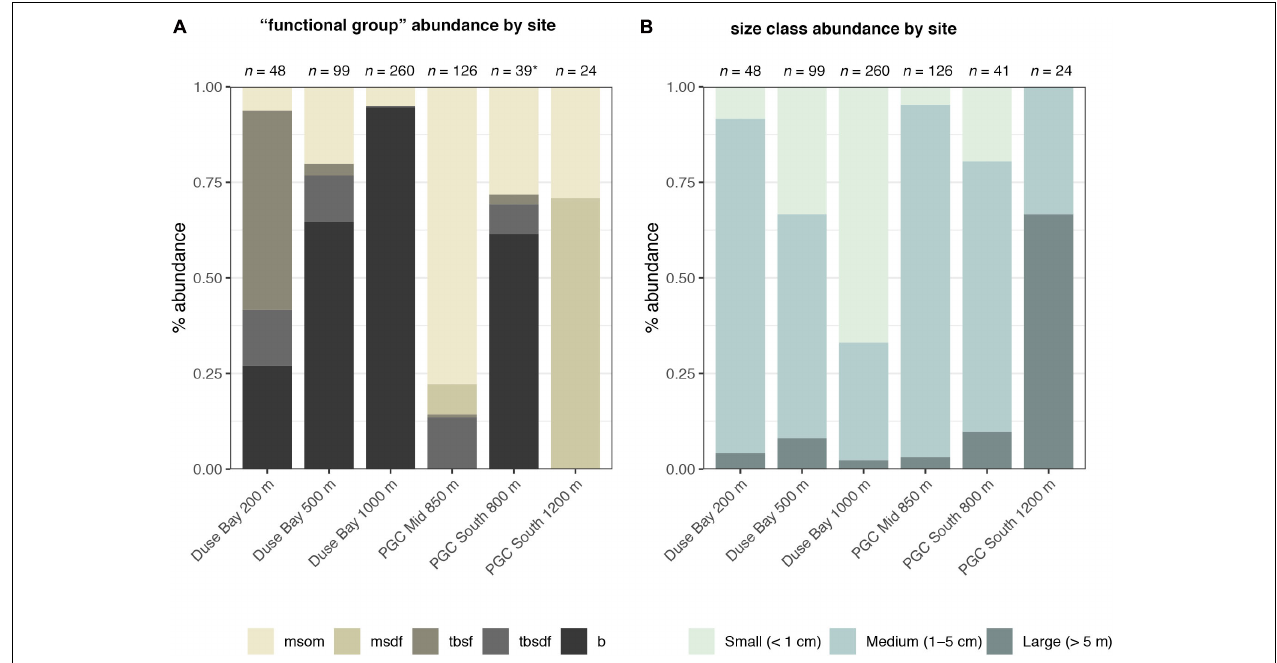
FIGURE 6 | Composition of annelid (A) “functional groups” and (B) size classes in terms of percentage abundance of individuals across all sampled AGT stations. (A) Polychete families were separated into broad functional categories based on shared functional traits such as life habit, motility and feeding behavior as follows: msom (motile surface-dwelling omnivorous); msdf (motile surface-dwelling deposit-feeding); tbsdf (tube-building surface deposit-feeding); tbsf (tube-building suspension-feeding); b (burrowing). See Table 2 for list of functional groups by family. * Singleton specimens representing parasitic (pa) and pelagic (pe) functional groups (see Table 2 ) were excluded from PGC South 800 m. (B) Specimens were organized into general size classes as follows: small (less than 1 cm in length); medium (between 1–5 cm in length, or for long, slender taxa, less than 0.5 cm in width); large (exceeding 5 cm in length and 0.5 cm in